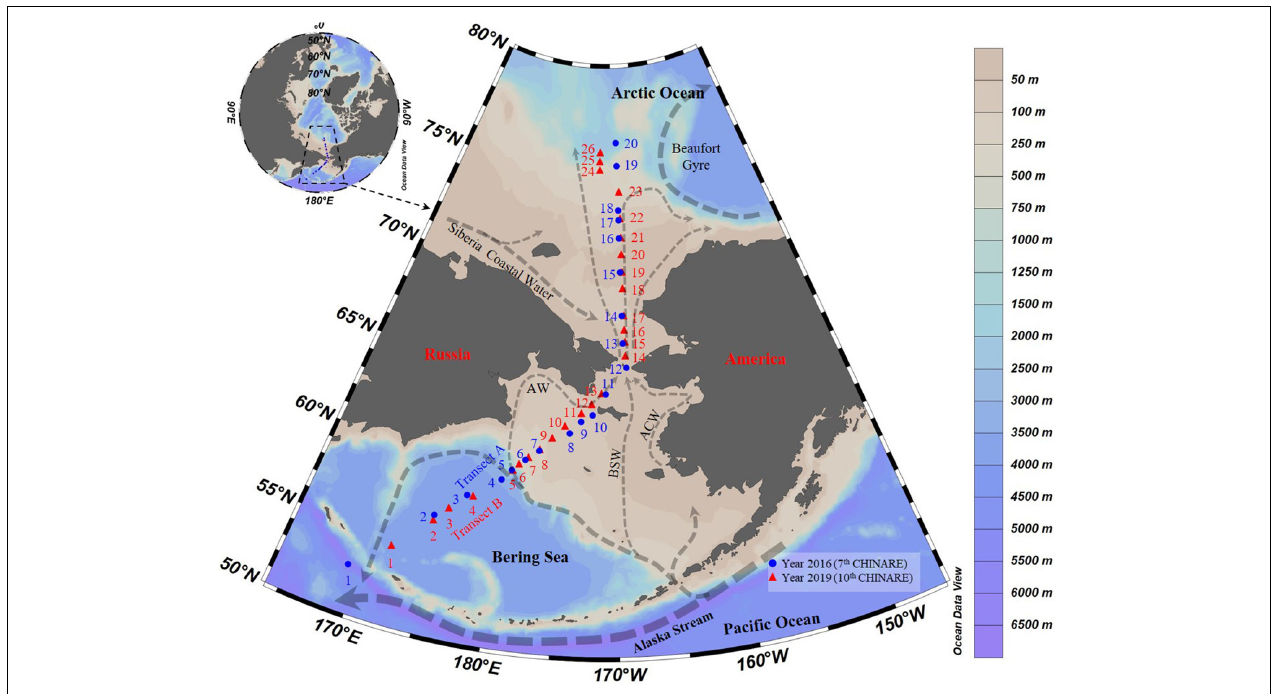
FIGURE 1 | Transects and survey stations from the Bering Sea to the Arctic Ocean in summer of 2016 and 2019. Arrows showed currents following Aksenov et al. (2016), Hunt et al. (2016), Zhong et al. (2019), and Andreev et al. (2020); AW, Anadyr Water; BSW, Bering Shelf Water; ACW, Alaskan Coastal Water.